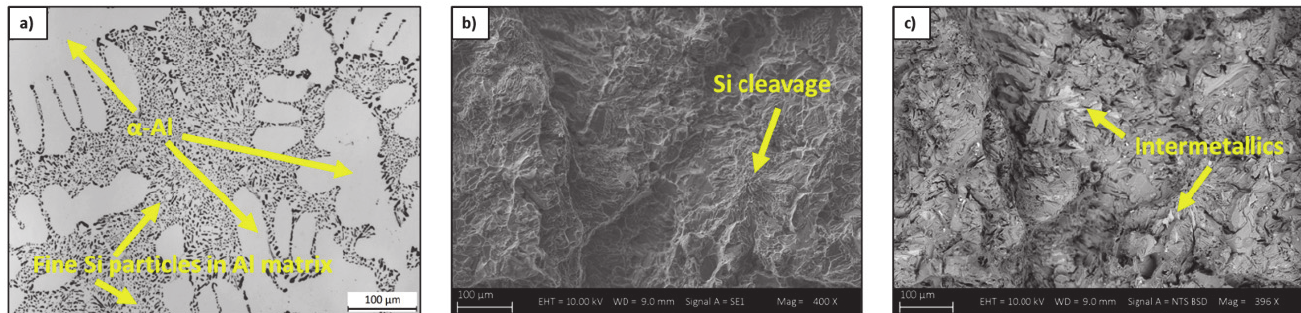
Figure 10: HIP 50 +T6 treated specimen: (a) microstructure at high magnification by optical microscopy; (b-c) fracture surface by scanning electron microscopy.